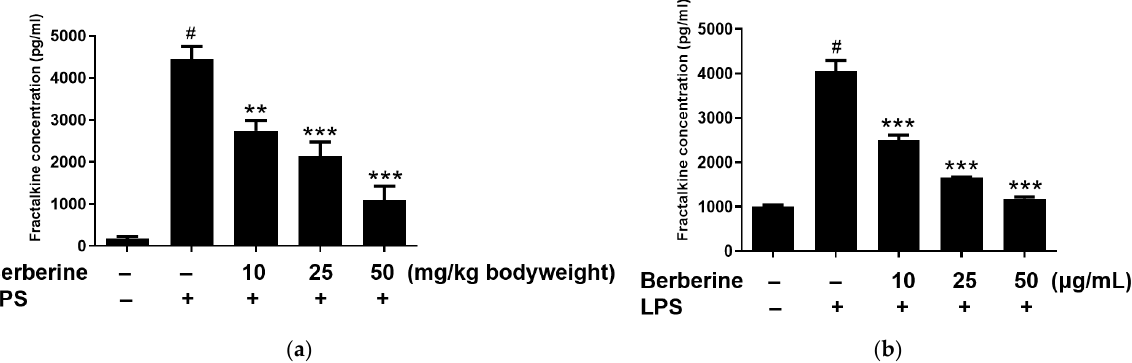
Figure 5. Berberine dose-dependently mitigated the lipopolysaccharide (LPS)-induced upregulation of soluble fractalkine in vivo and in vitro. ( a ) Rats were intraperitoneally pretreated with berberine at doses of 10, 25, or 50 mg/kg bodyweight for 1 h, followed by administration with LPS (5 mg/kg body weight). The serum levels of soluble fractalkine were examined using enzyme-linked immunosorbent assay (ELISA) and the results are represented in the bar graph (mean ± standard error of mean (SEM)). ( b ) Human umbilical vein endothelial cells were pretreated with 10, 25, or 50 µ g/mL berber- ine, followed by stimulation with 5 µ g/mL LPS for 4 h. Soluble fractalkine concentration in the conditioned medium was measured using ELISA and the results are represented in the bar graph (mean ± SEM). # p < 0.001 compared with the control group; ** p < 0.01 compared with the LPS group; *** p < 0.001 compared with the LPS